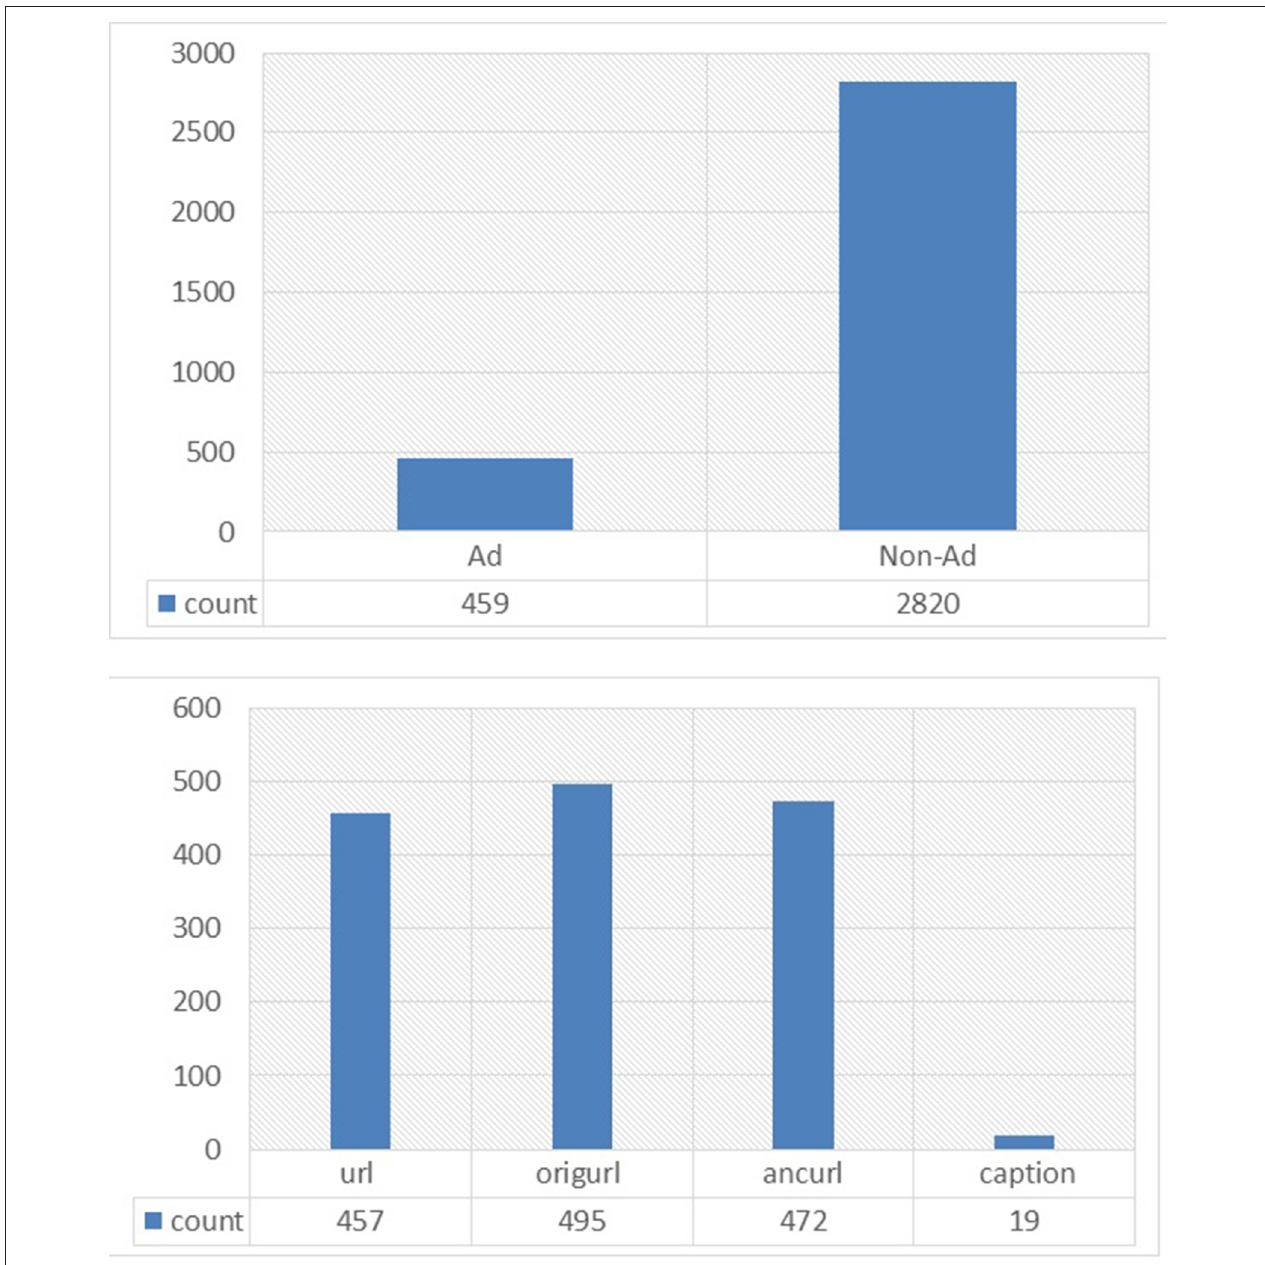
FIGURE 9 | Binomial class